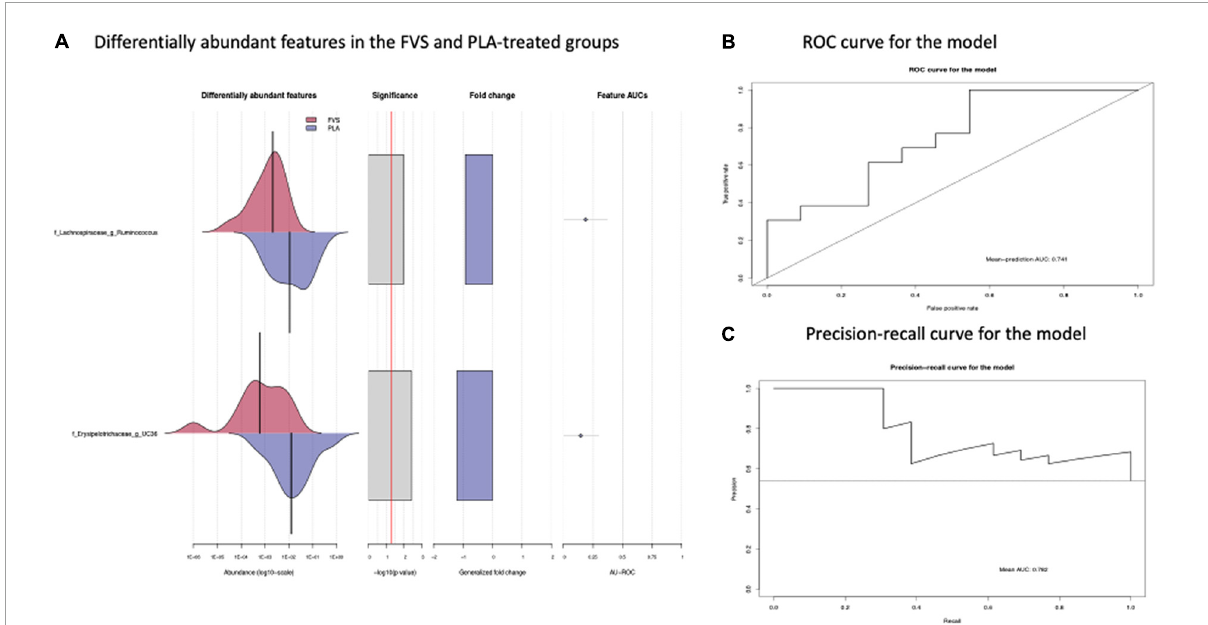
FIGURE4 Validation of gut microbial markers using a machine learning tool—SIAMCAT analysis. (A) Gut microbial markers from LEfSe analysis were further validated using the SIAMCAT tool, which showed L- Ruminococcus and Erysipelotrichaceae family bacteria are significantly enriched in the PLA-treated group. (B) ROC curve for model, which displayed the cross-validation error as a receiver operating characteristic (ROC) curve with the 95% confidence interval. The area under the ROC (AUROC = 0.741) is given below the curve. The x -axis and y -axis represent false-positive and true-positive rates, respectively, for the tested markers, and (C) precision–recall curve for the model, which displays the mean AUC value of 0.782. An AUROC value of more than 0.7 is considered fairly good in terms of the discriminative ability of the test.